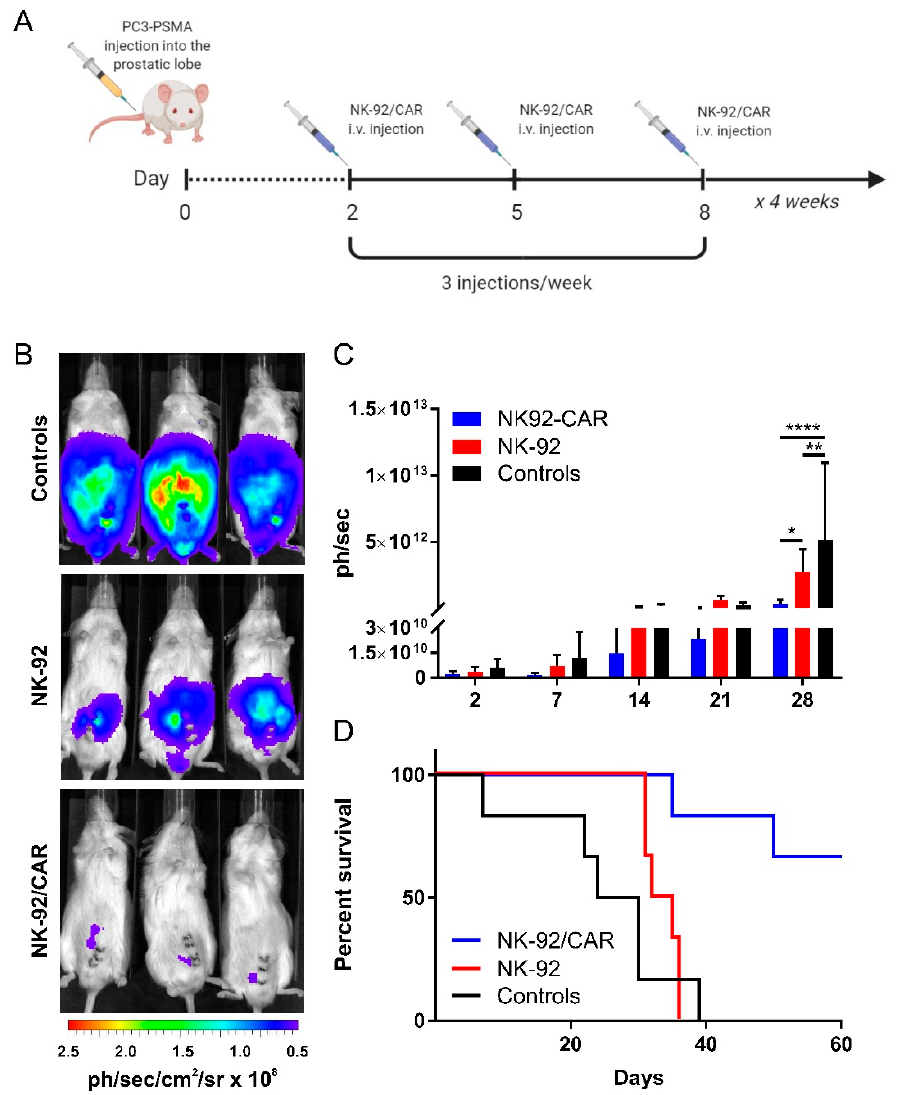
Figure 6. Antitumor activity of NK-92 / CAR cells against orthotopic PC3-PSMA xenografts. ( A ) Representative schedule of the experiment. Luciferase-expressing PC3-PSMA cells were injected into the anterior prostatic lobe of NSG mice. Starting from two days later, mice received i.v. injections of NK-92 / CAR or parental NK-92 cells thrice per week for 4 weeks. Control mice were treated with PBS, and tumor growth was monitored by BLI. ( B ) Representative images of mice from experimental groups (one mouse / group) at day 28. ( C ) Graph reports cumulative results of the regions of interest (ROI) in total body. Tumor growth was monitored as total flux (ph / sec). Graphs show mean ± SD of three independent experiments. ( D ) Cumulative Kaplan–Meier survival curves of NSG mice (untreated mice, black line; NK-92 treated mice, red line; NK-92 / CAR treated mice, blue line). * p < 0.05, ** p < 0.01 and *** p < 0.001.